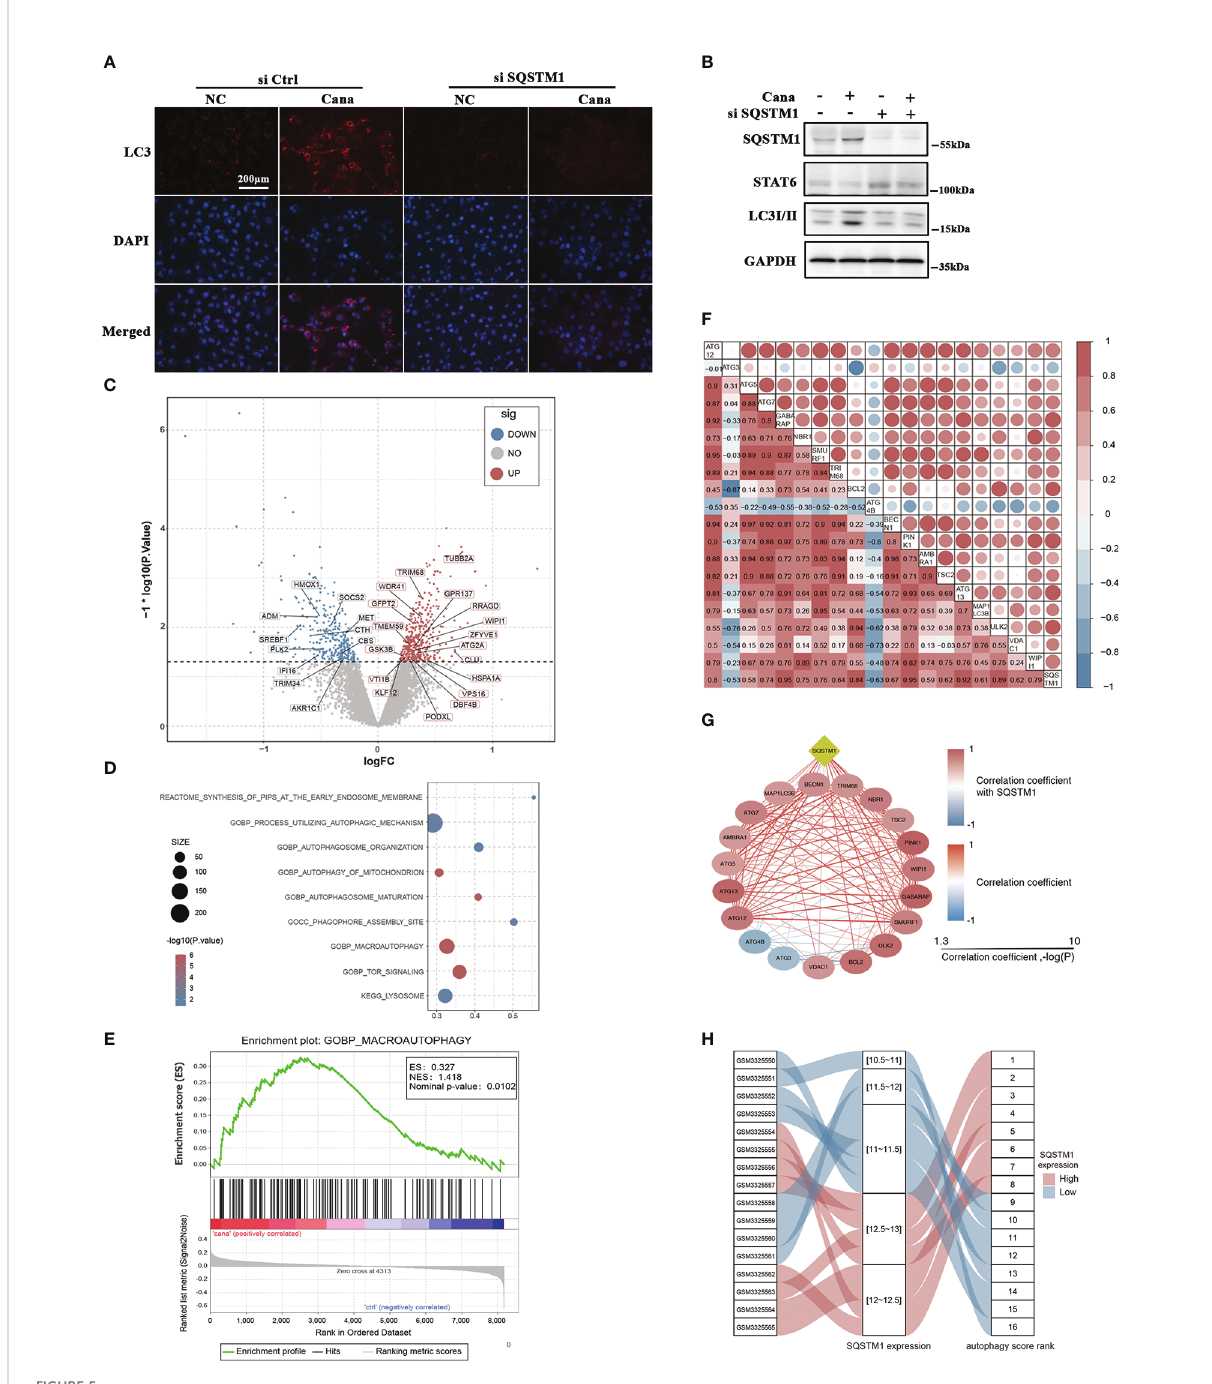
FIGURE 5 Autophagy was signi fi cantly associated with SQSTM1/P62 and Cana. (A, B) HK2 cells were transfected with or without SQSTM1 siRNA. Followed by 24 h serum-free medium culture, cells were treated with or without Cana (20 m M) for another 24 h. (A) Representative microphages of immuno fl uorescence from the indicated group are shown. (B) Immunoblot analyses was performed. (C) Volcano map showing that DEGs between Cana treated and control samples with autophagy-related genes were labeled. (D) Functional enrichment analysis of DEGs. (E) Gene set enrichment analysis result. (F, G) Correlation between SQSTM1 and genes related to autophagy. (H) The variation of SQSTM1 expression level and its corresponding autophagy score rank shown by alluvial